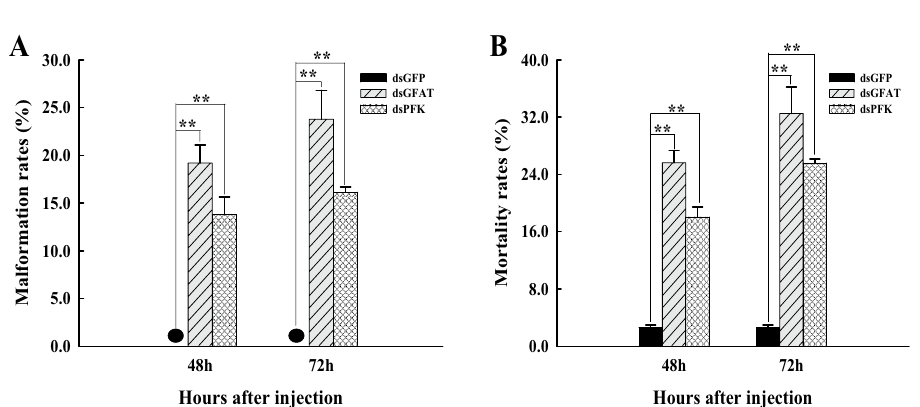
Figure 4. Malformation rates ( A ) and mortality ( B ) rates of Nilaparvata lugens at 48 h and 72 h after dsRNA injection. GFAT, glutamine:fructose-6-phosphate aminotransferase; PFK, phosphofructokinase. The N. lugens used for the microinjection of RNAi were at the 1st day of the 5th instar nymph stage and dsGFAT or dsPFK injection were used as the test groups whereas dsGFP injection was used as the control group. This experiment had three biological repeats. *, significant differences ( P < 0.05); **, extremely significant differences ( p < 0.01). The deformity rate of the dsGFP treatment group was zero, with “ ” indicating the ●